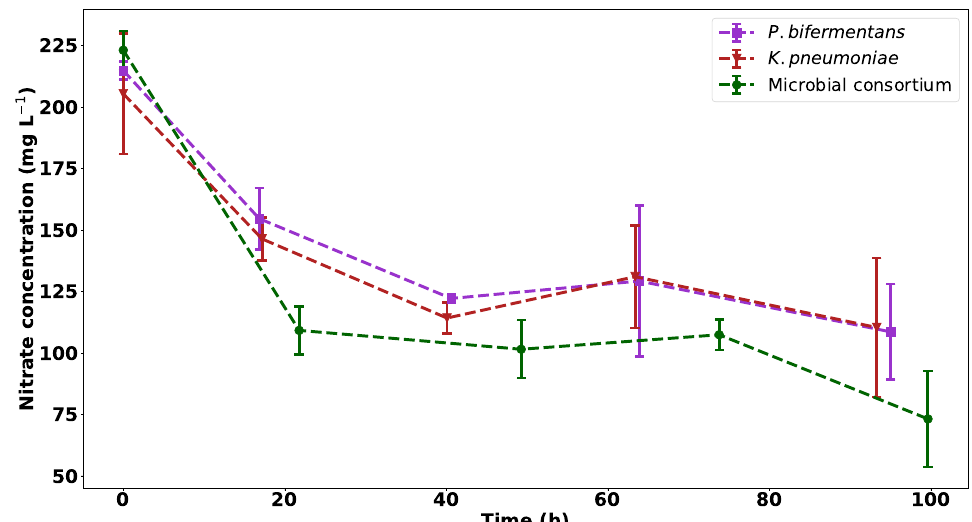
Figure 4. The nitrate concentration of the samples in the three experimental runs over 100 h, with n =